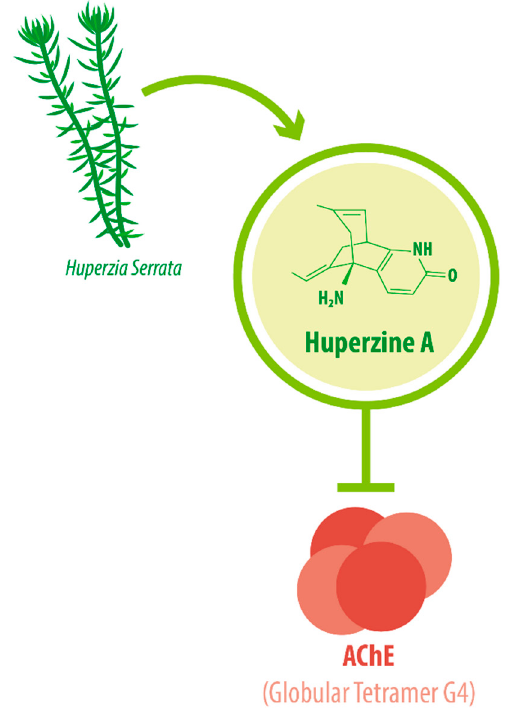
Figure 1. HupA is an acetylcholinesterase inhibitor (AChEI). HupA has a molecular weight of 242.32 g/mol and acts by inhibiting AChE. In the CNS, AChE is present in a tetrameric form anchored to the membrane, or “Globular Tetramer G4” (G4). HupA is the main biological compound in H. serrata , which has been used with medicinal purposes in China for centuries. (AChE: acetylcholinesterase; CNS: central nervous system).